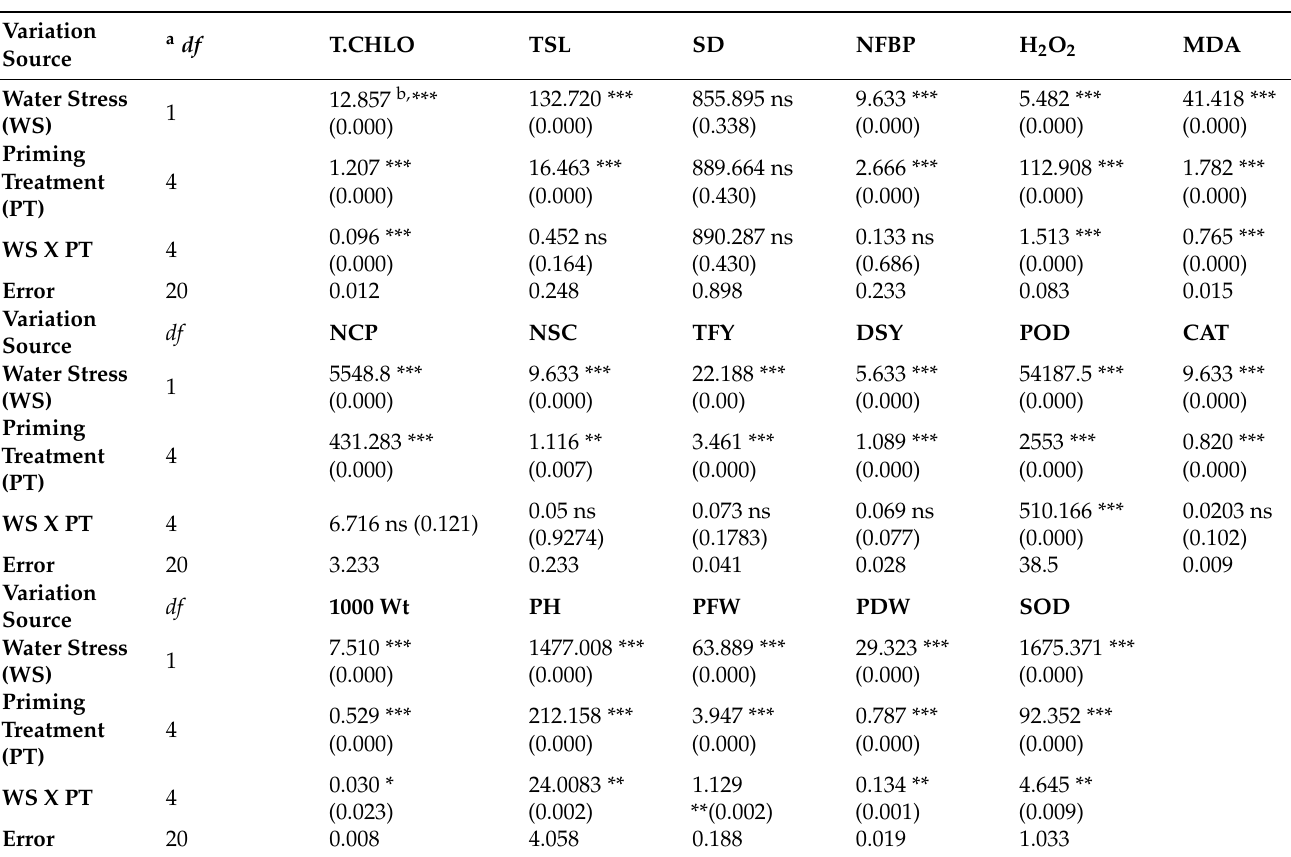
Table 4. Physiochemical parameters of flax seeds measured after seed priming using iron oxide NPs and analyzed through ANOVA (with mean square and p